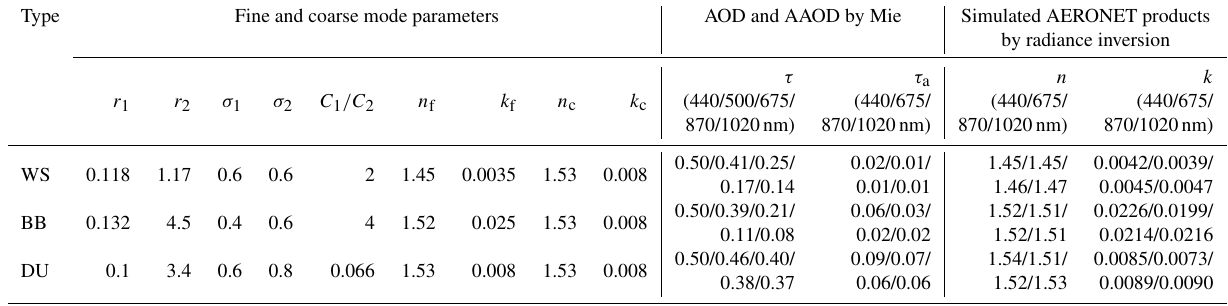
Table 1. Typical aerosol models (WS: water soluble, BB: biomass burning, DU: dust) and their sub-mode parameters. Type Fine and coarse mode parameters AOD and AAOD by Mie Simulated AERONET products